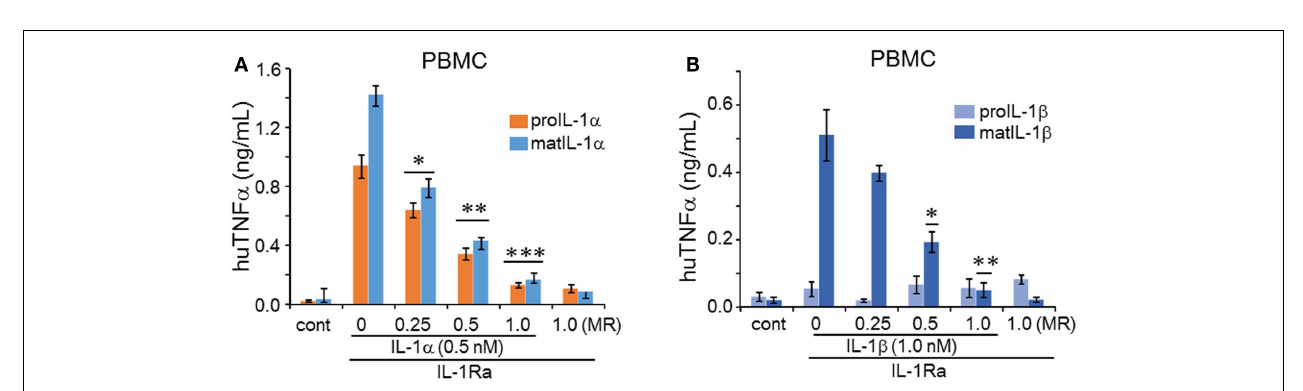
mature recombinant IL-1 α (A) and in (B) 1.0nM of precursor or mature recombinant IL-1 β .TNF α levels in the supernatants represent mean ±